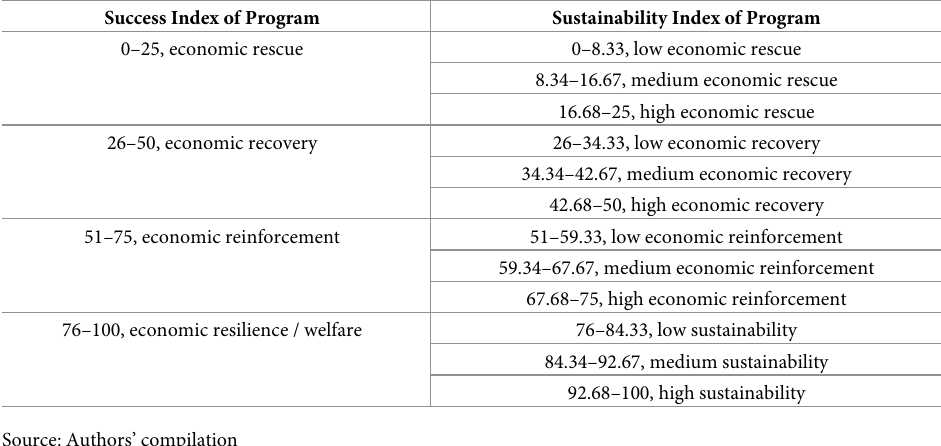
Table 3. Success and sustainability index of Islamic Social Finance program. Success Index of